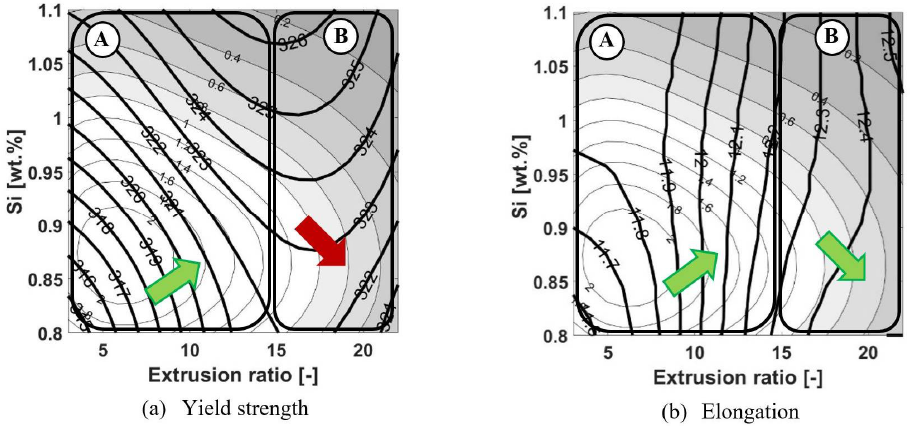
Figure 4. Common influence of extrusion ratio and Si content on ( a ) yield strength and ( b ) elonga- tion. Green (grey) and red (dark) arrows indicate increase and decrease of the observed mechanical property.